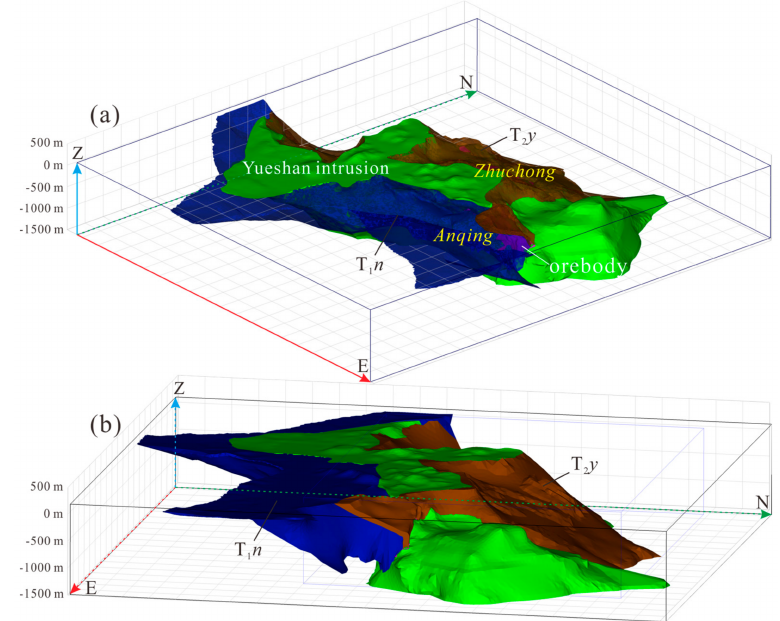
Figure 3. ( a ) 3D models of the Yueshan intrusion, the strata of T 1 n and T 2 y , and orebodies; ( b ) the view from